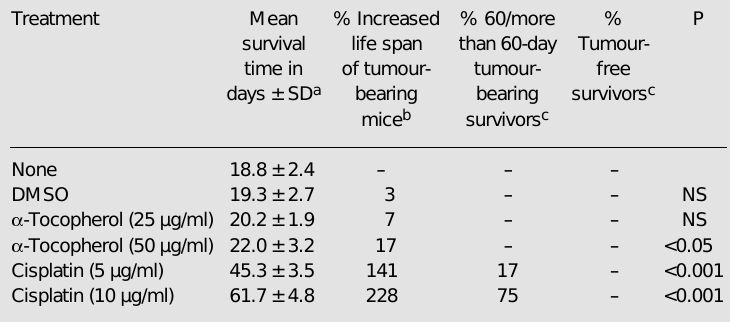
Table 1 - Increased mean survival time and percent increased life span after inoculating tumour cells incubated with cisplatin and/or a